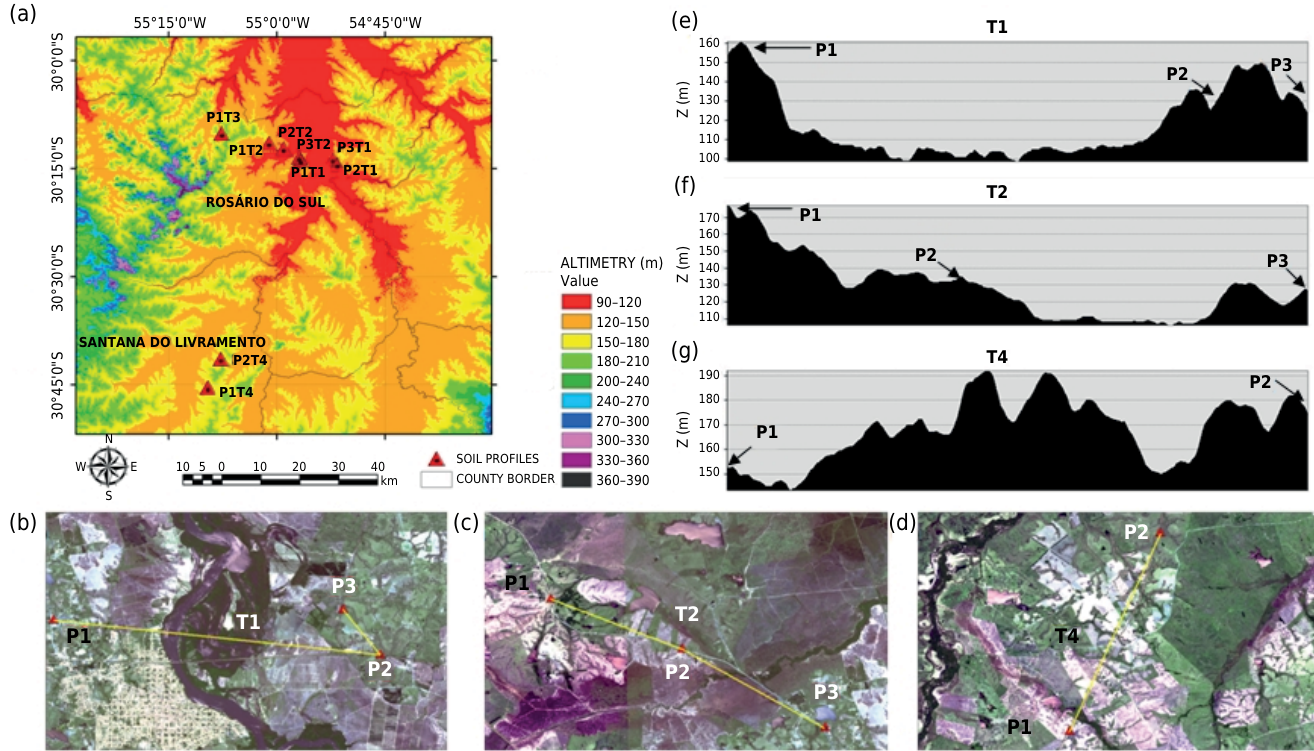
Figure 2. (a) Altimetric map of the region ( Datum SAD69 - scale indicated); Tracing of the topolito-sequences: T1 (P1, P2 and P3 profiles) (b), T2 (P1, P2 and P3 profiles) (c) and T4 (P1 and P2 profiles) (d) (RapidEye Image Composition 3R2G1B - without scale); topographic profile map of the topolitho sequences T1 (e), T2 (f) and T4 (g) built from the MDE (without